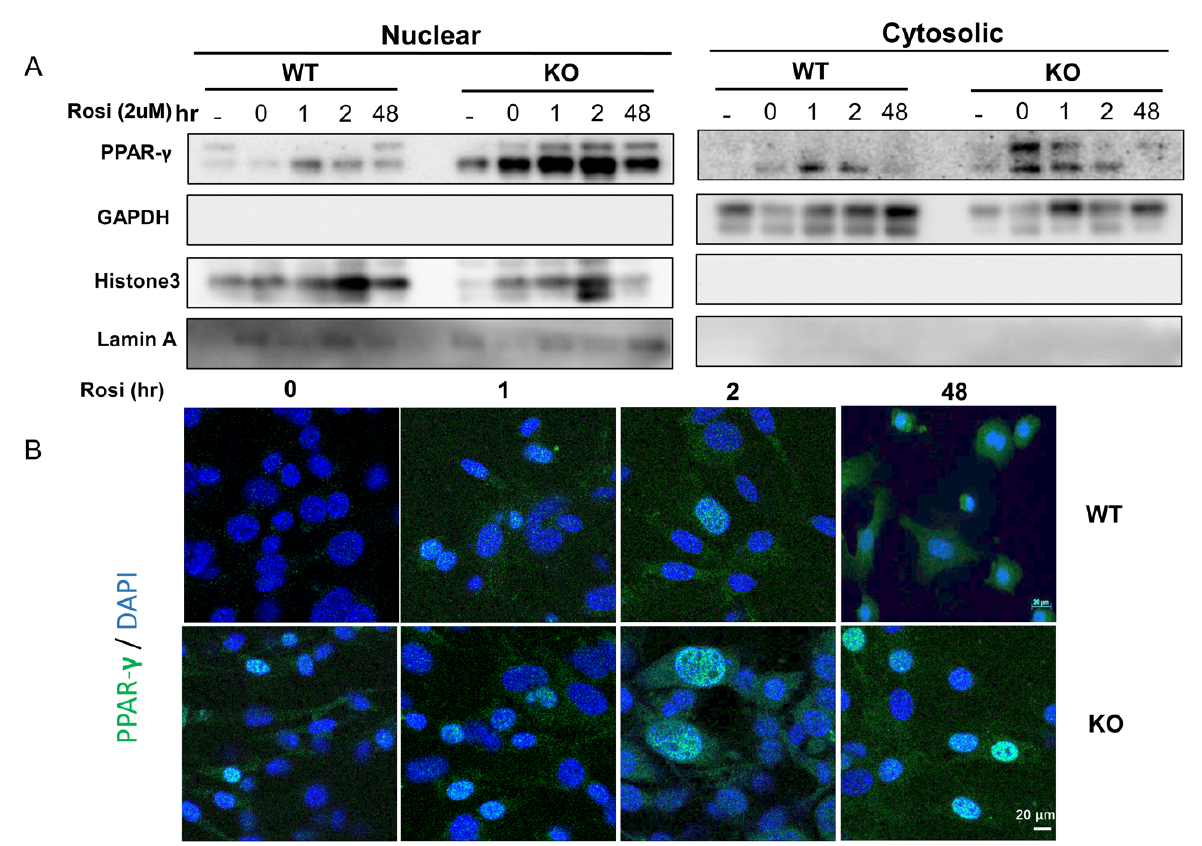
Figure 4. SPL KO vWAT adipocytes promoted/retained more PPAR- γ in the nuclear after Rosiglitazone stimulation. Browning was induced in SVF vWAT adipocytes for 2 days and then treated with rosiglitazone at 2 µ M for another 48 h. (A) Western blot of PPAR- γ , GAPDH, Histone 3, and Lamin A in the nuclear fraction or cytosol fraction of vWAT harvested from WT and SPL KO mice before (0 h) and at 1 h, 2 h, and 48 h post-rosiglitazone treatment. ( B ). Immunofluorescent staining of PPAR- γ in WT and KO mice before (0 h) and 1 h, 2 h, and 48 h post Rosiglitazone treatment. Data were from at least three individual experiments. Scale bar = 20 µ m.